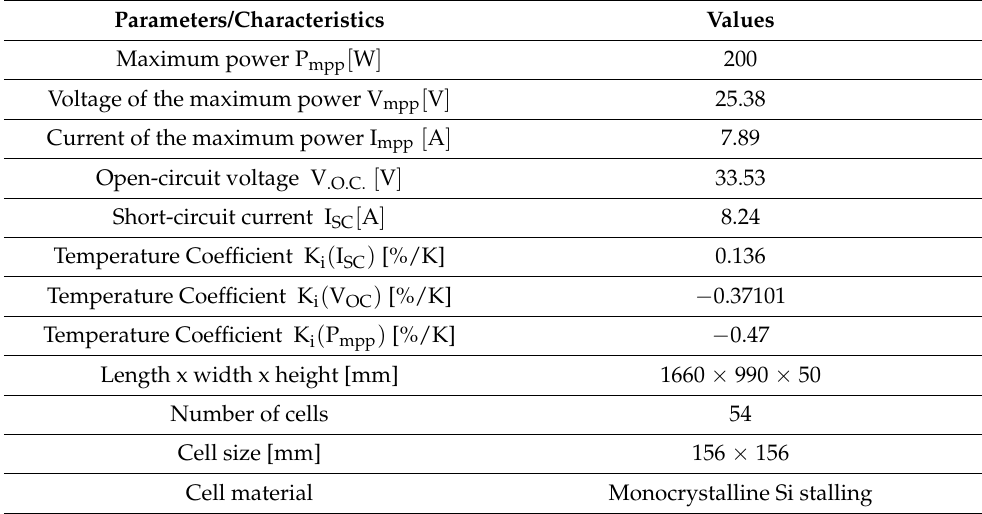
Table 2. Characteristics of the APOLLO SOLAR ENERGY ASEC-200G6S module.